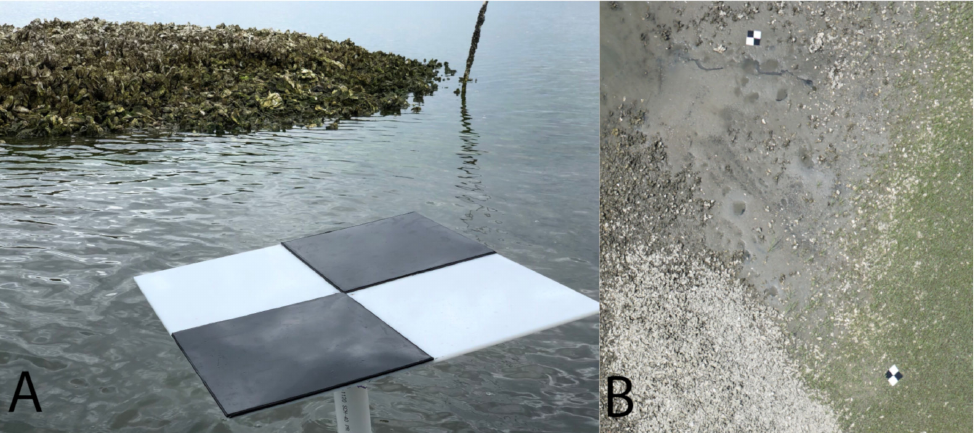
Figure A1. ( A ) GCP deployed in Town Marsh, ( B ) GCPs from UAS imagery collected in Town